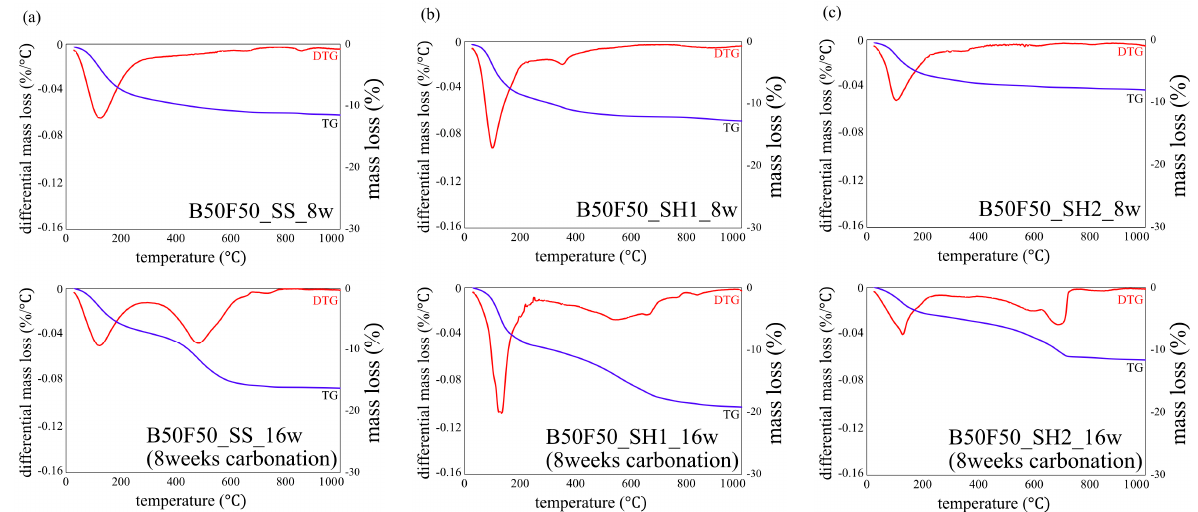
Figure 9. Thermogravimetric/differential thermal gravimetric (TG/DTG) analysis results for specimens of ( a ) B50F50_SS_8w